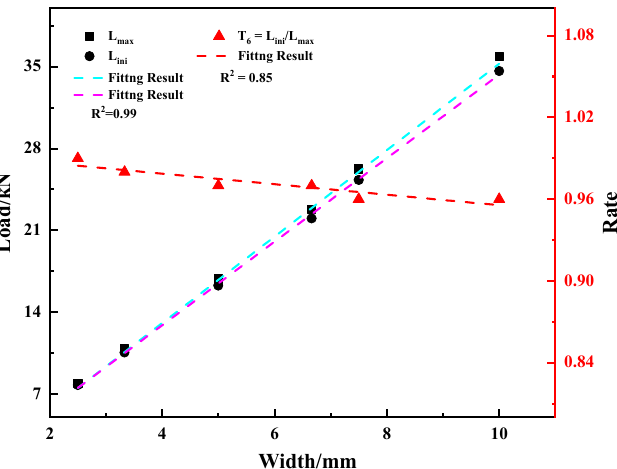
Figure 22. Variation of characteristic load and its ratio with sample width.